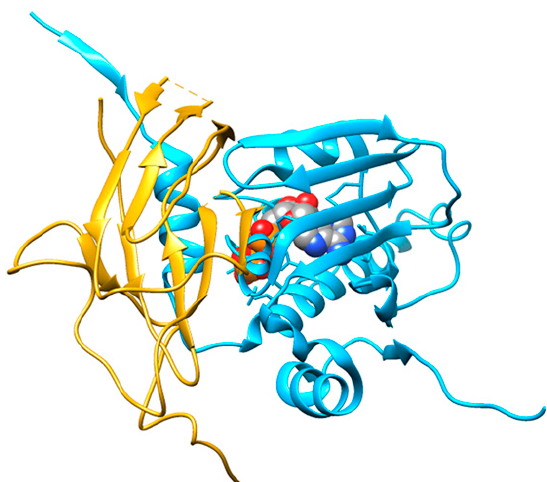
Figure 2. Crystal structure of yeast Hsp90/ATP/p23 closed chaperone complex (PDB ID: 2CG9). The Hsp90 N -terminal domain is shown in cyan, the p23 co-chaperone is in